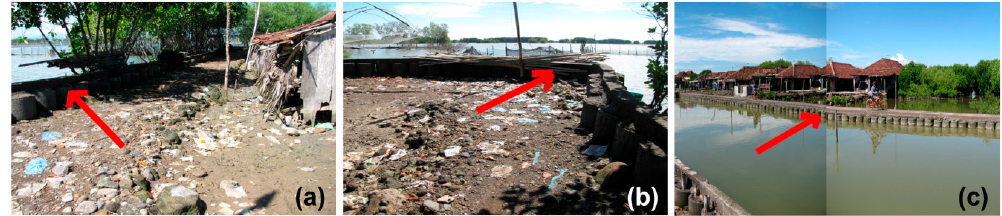
Figure 15. The embankment (shown by red arrows) for protecting the settlements ( a – c ). ( c ) shows the river and settlements built on the river banks prone to high tides from both the sea and the river.